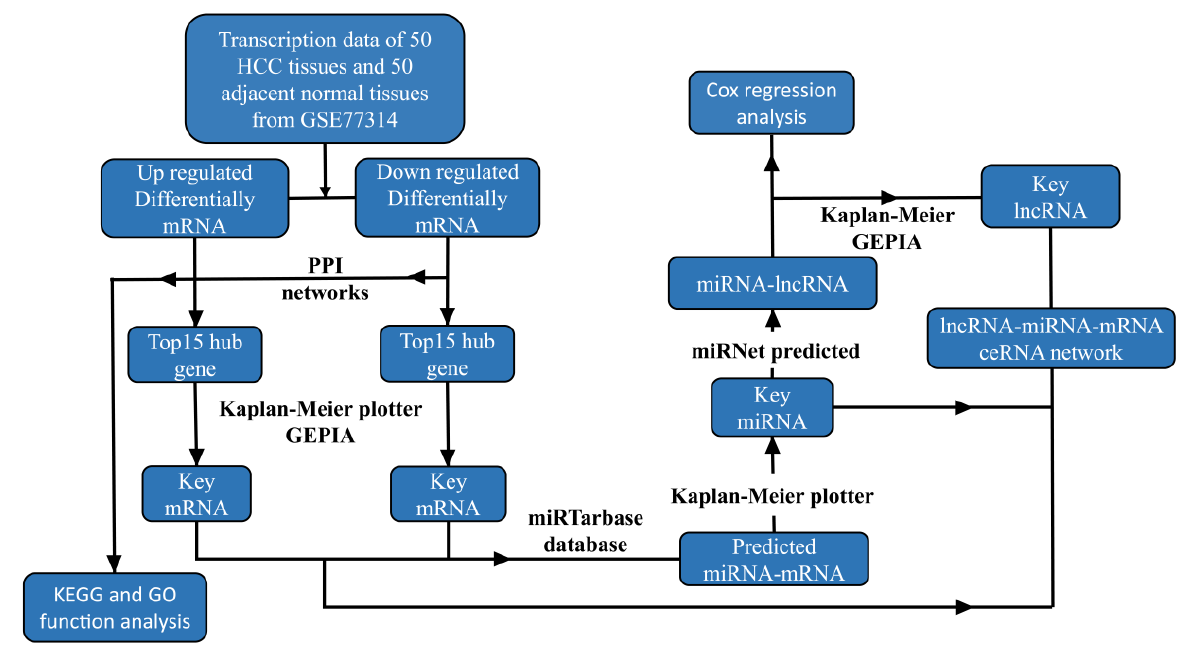
Figure 1. The workflow of ceRNA network study in HCC .